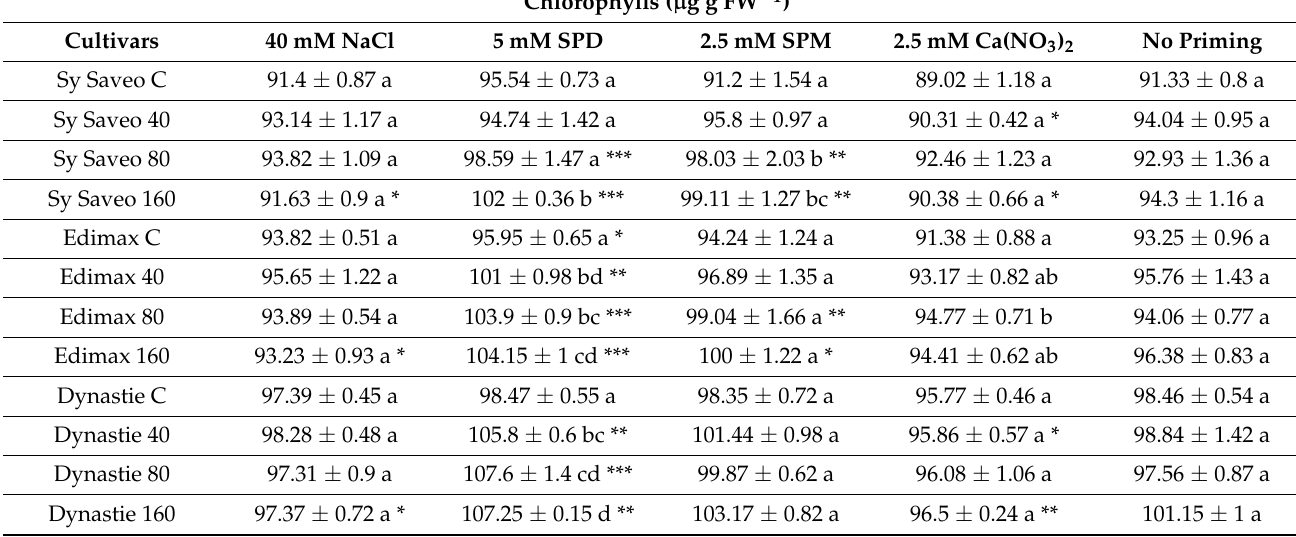
Table 5. Effect of different priming agents on total chlorophyll content ( µ g g FW − 1 ) of rapeseed cultivars exposed to different saline conditions: 0 mM NaCl (C), 40 mM NaCl (40), 80 mM NaCl (80), 160 mM NaCl (160). Data are expressed as means ± SE ( n = 8). Mean values in the column marked by different letters are significantly different within the same group ( p ≤ 0.05; ANOVA and Tukey–Kramer test). Significant differences between groups are reported as * p < 0.05; ** p < 0.01; *** p < 0.001.